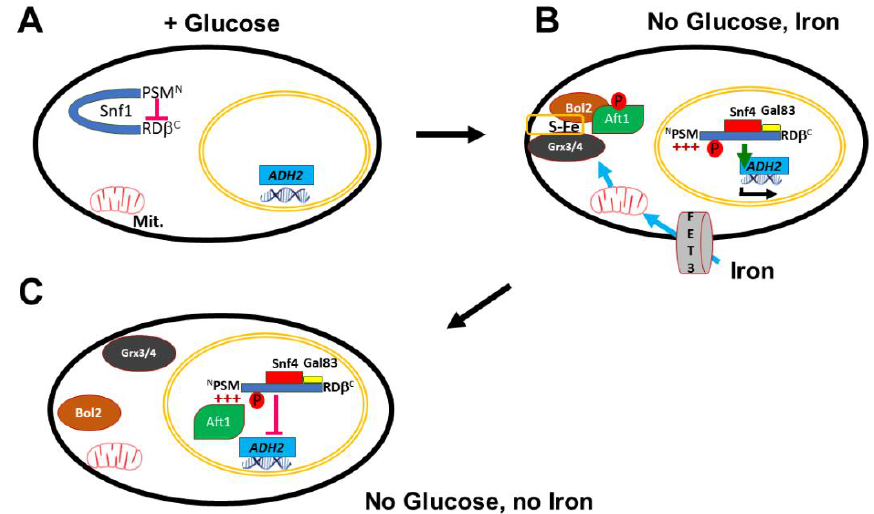
Figure 7. Model. ( A ) In the presence of glucose, the PSM is deprotonated and interacts with RD- γ , T210 is not phosphorylated and Snf1 is inactive. ( B ) In the absence of glucose, T210 is phosphorylated and the PSM is protonated and disengages from RD- γ . Snf4 and a γ -subunit interact with the RD. Snf1/Snf4/Gal83 localize to the nucleus and genes, such as ADH2, are expressed. Iron is imported and iron–sulfur clusters are manufactured in the mitochondria. These interact with Grx3/4 and Bol2 to sequester Aft1 in the cytoplasm. Aft1 is also phosphorylated by Hog1 at S210 and S224 and this leads to its export from the nucleus by Msn5. ( C ) In the absence of iron or glucose, Aft1 enters the nucleus and interacts at the nuclear membrane with the protonated PSM of Snf1, thereby inhibiting Snf1.